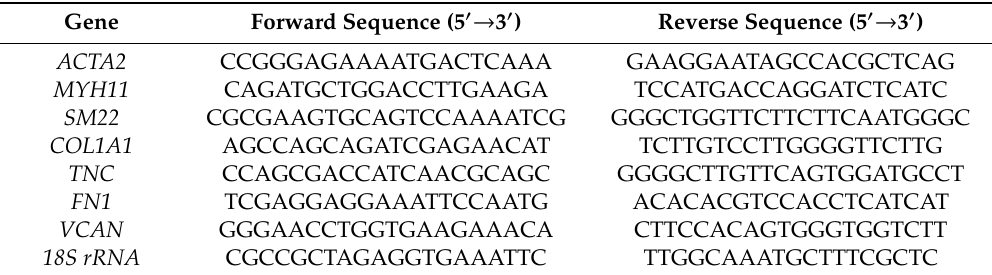
Table 3. Sequences of primers